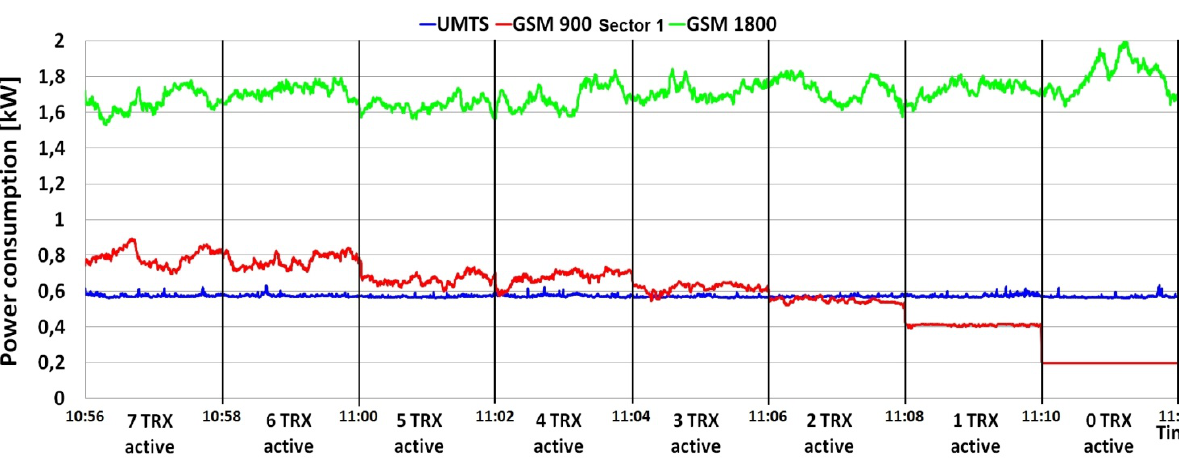
Figure 11. Power consumption of BSs during deactivation of TRXs in GSM 900 BS cabinet.